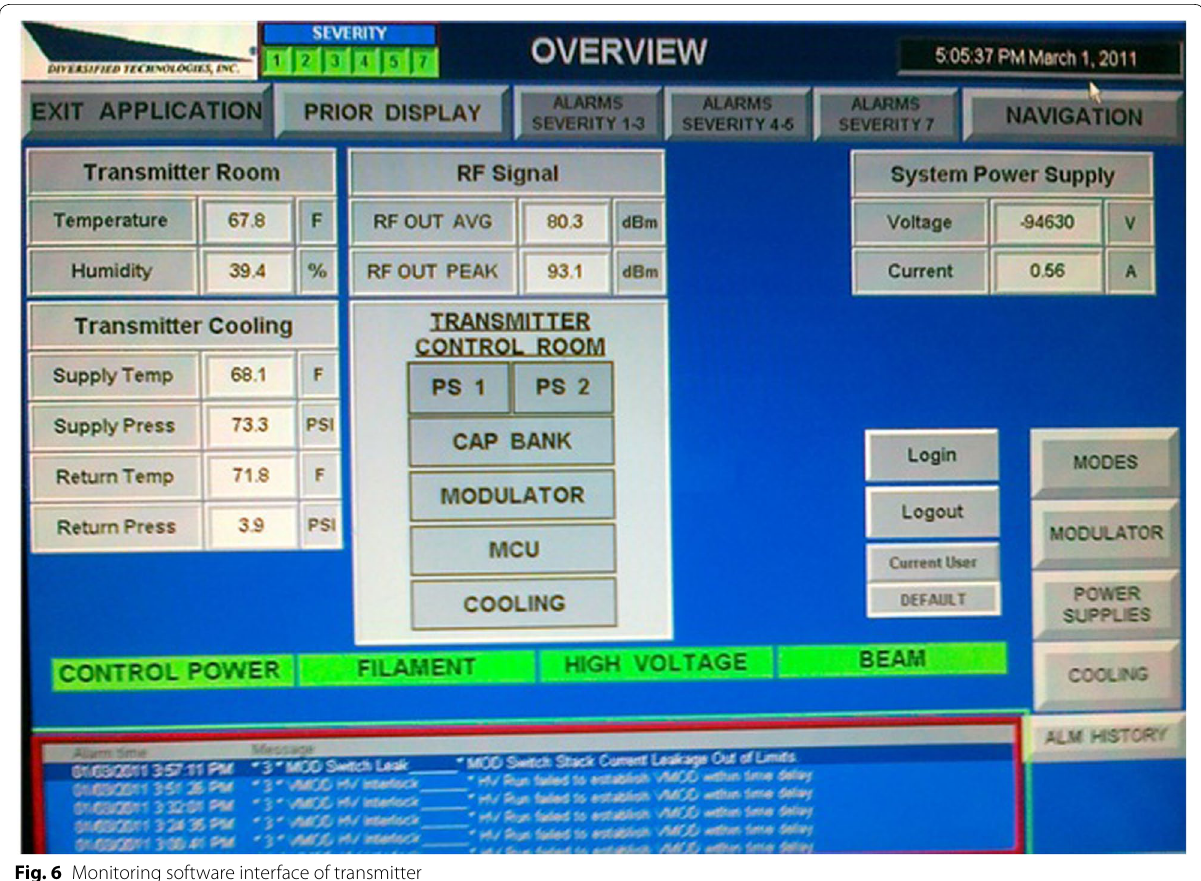
Fig. 6 Monitoring software interface of transmitter